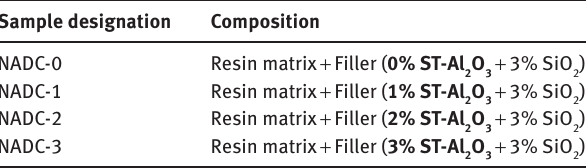
Table 1: Detailed composition of dental composite filled with nanoalumina and nanosilica